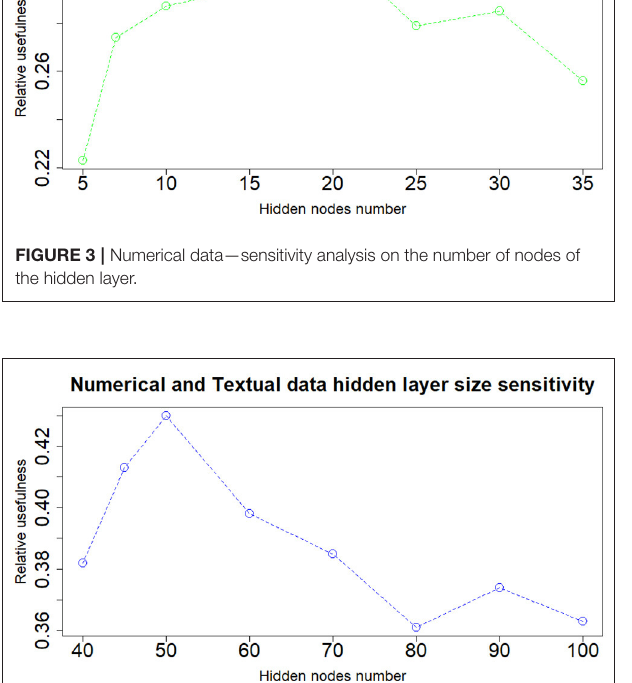
supervised framework to associate specific language and financial figures with the target bank status for the given period (tranquil or